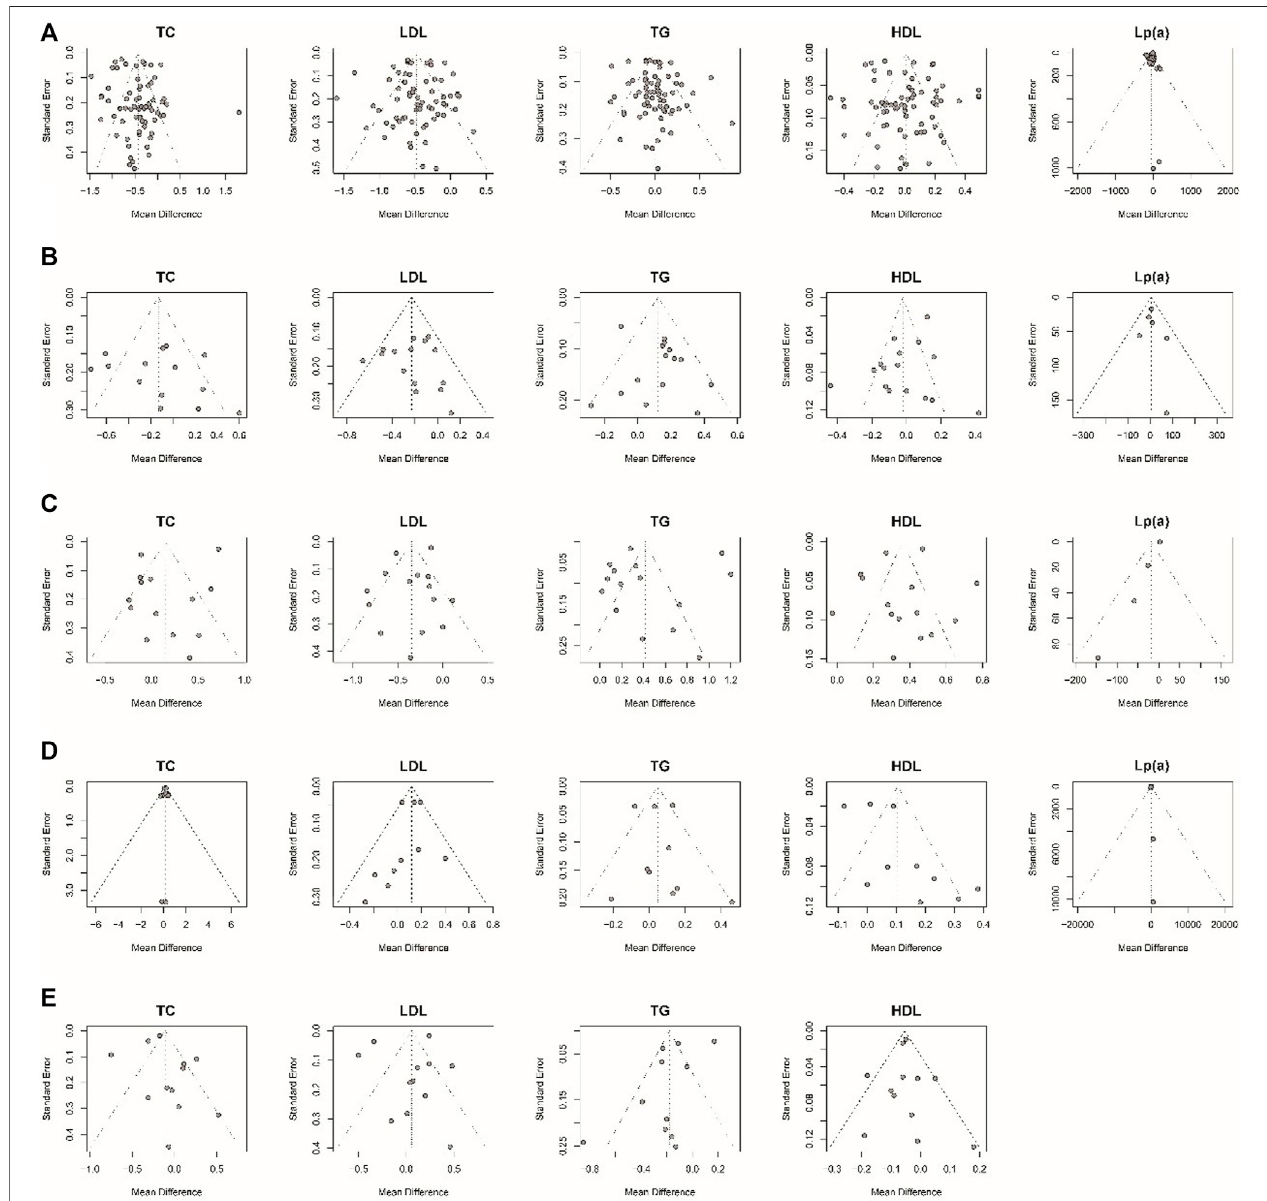
FIGURE11| Funnelplotsexaminingpublicationbias.TheEggertestsuggestedthattherewasnoevidenceofpublicationbiasinstudieswithmorethan10articles. (A) MHT vs. Placebo or no treatment; (B) oral MHT vs. transdermal MHT; (C) Conventional MHT vs. Tibolone; (D) Estrogen vs. Estrogen-Progestogen; (E) Low-dose MHT vs. Conventional